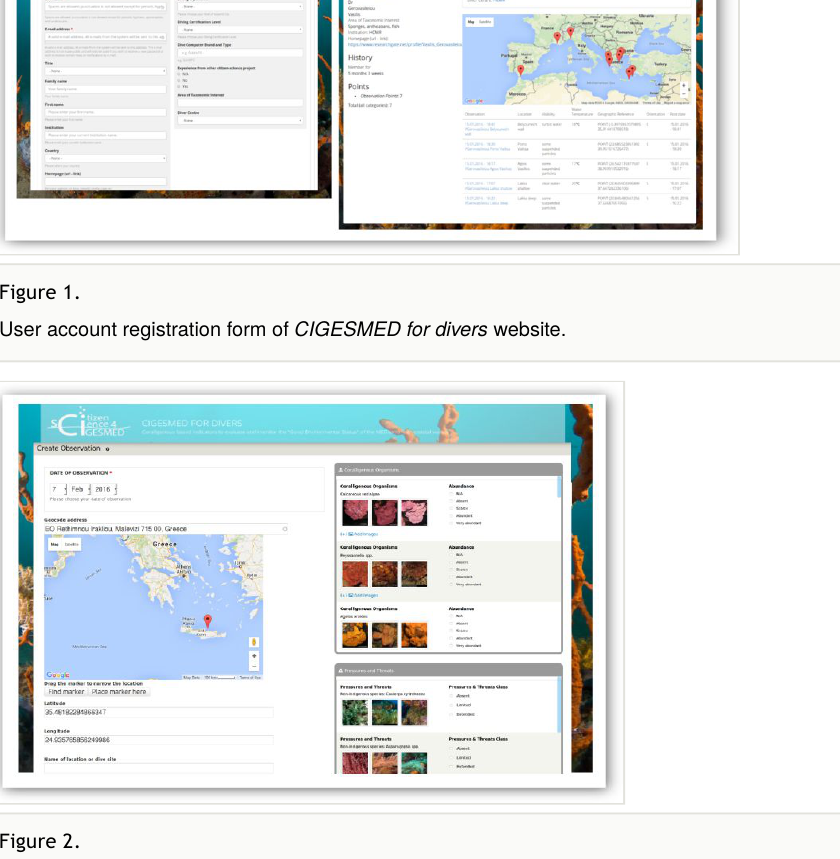
Observation form in the data submission platform of the CIGESMED for divers